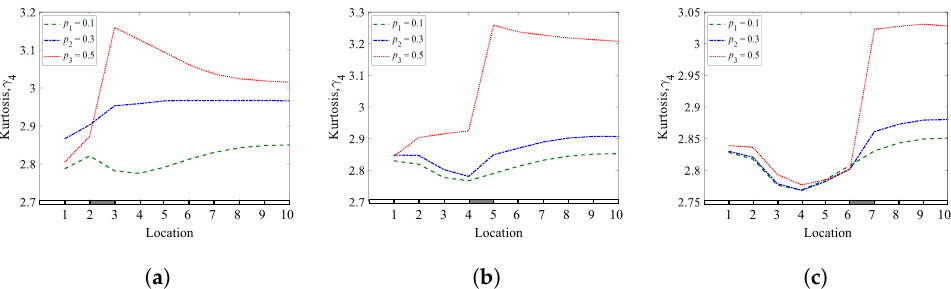
Figure 11. Kurtosis coefficients of a cantilever beam for different crack depths and locations: ( a ) q 1 = 0.25; ( b ) q 2 = 0.45; ( c ) q 3 =